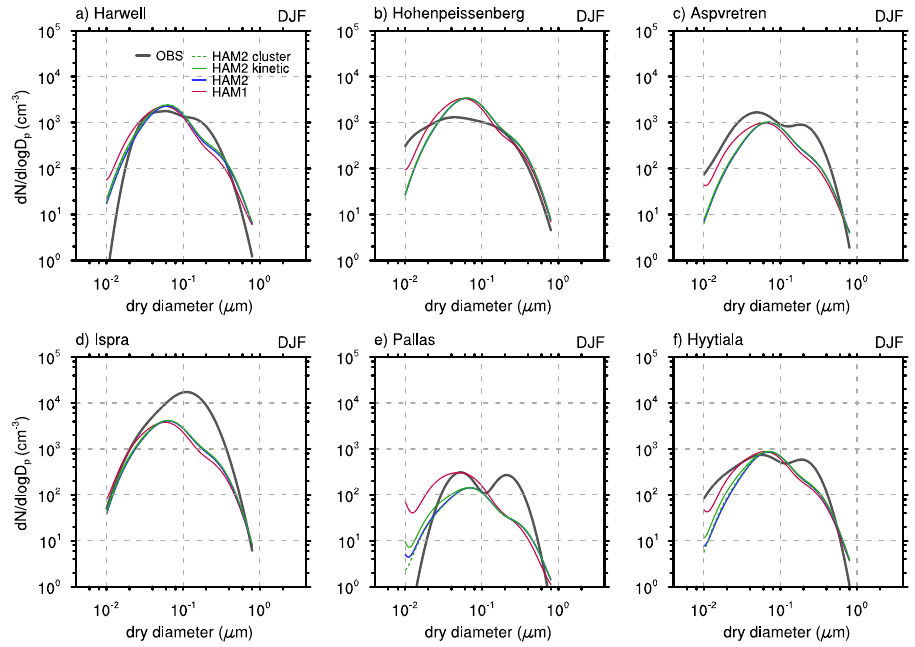
Fig. 14. Comparison of the simulated and measured aerosol size distributions in the planetary boundary layer over land in boreal winter (December-January-February). The thick black curves are the observed median size distributions from Putaud (2003) and Tunved et al. (2003). Model results (the colored curves) are plotted only for the diameter range between 0.01 and 0.8µm because this is the range measured in the references. Note that most parts of the dotted lines underlie solid color lines.